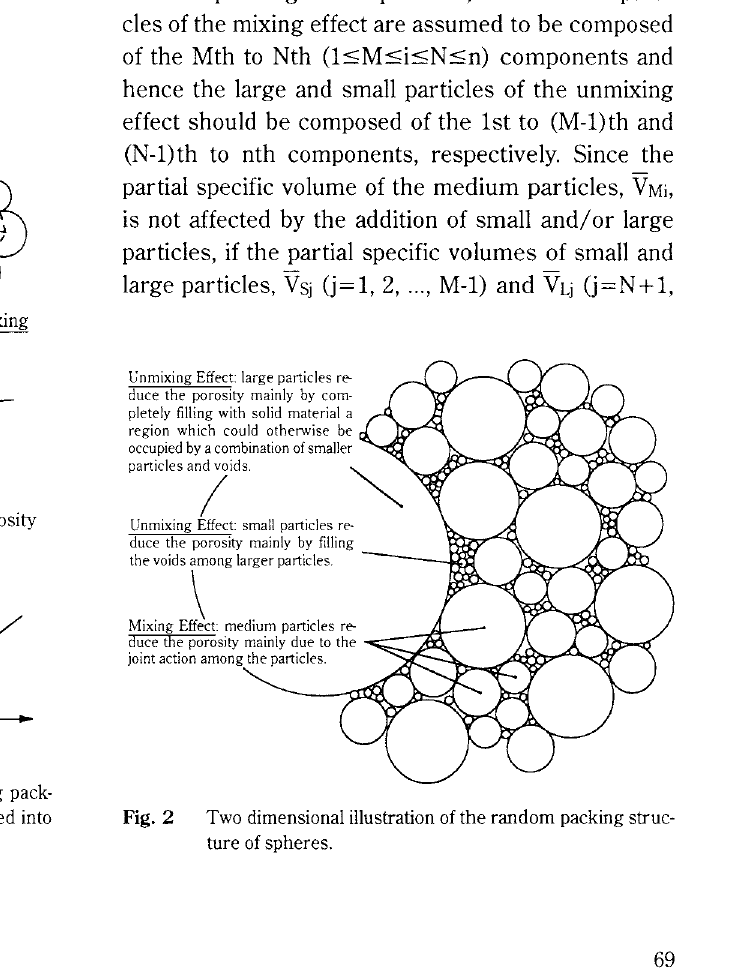
Schematic illustration of the mixing and unmixing pack ing mechanisms when small spheres are introduced into the packing oflarge spheres.